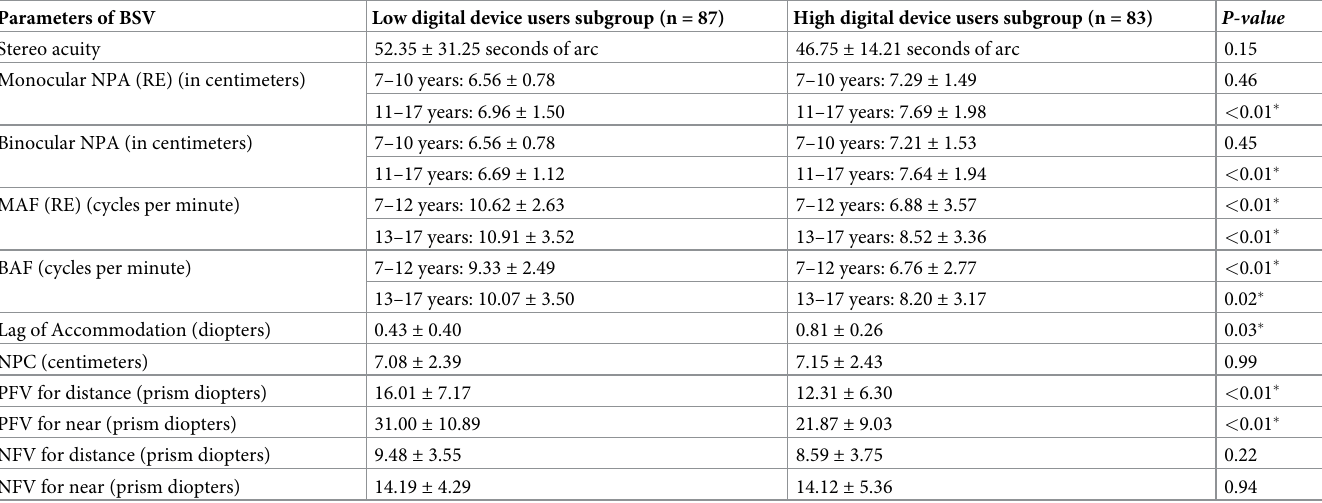
Table 4. Binocular vision findings between low and high digital device users